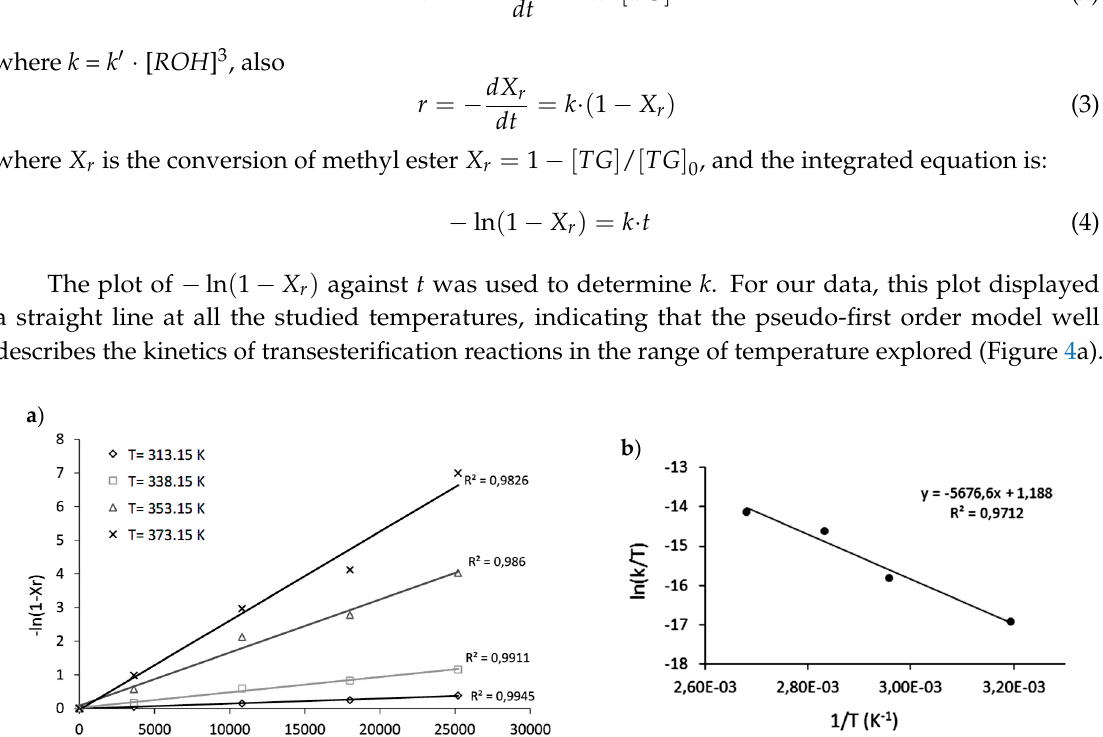
Table 1. kinetic ( Ea ) and thermodynamic parameters of activation ( Δ G ‡ and Δ H ‡ ) for ZnO/TBAI catalyzed methanol transesterification reaction of soybean oil 1 .